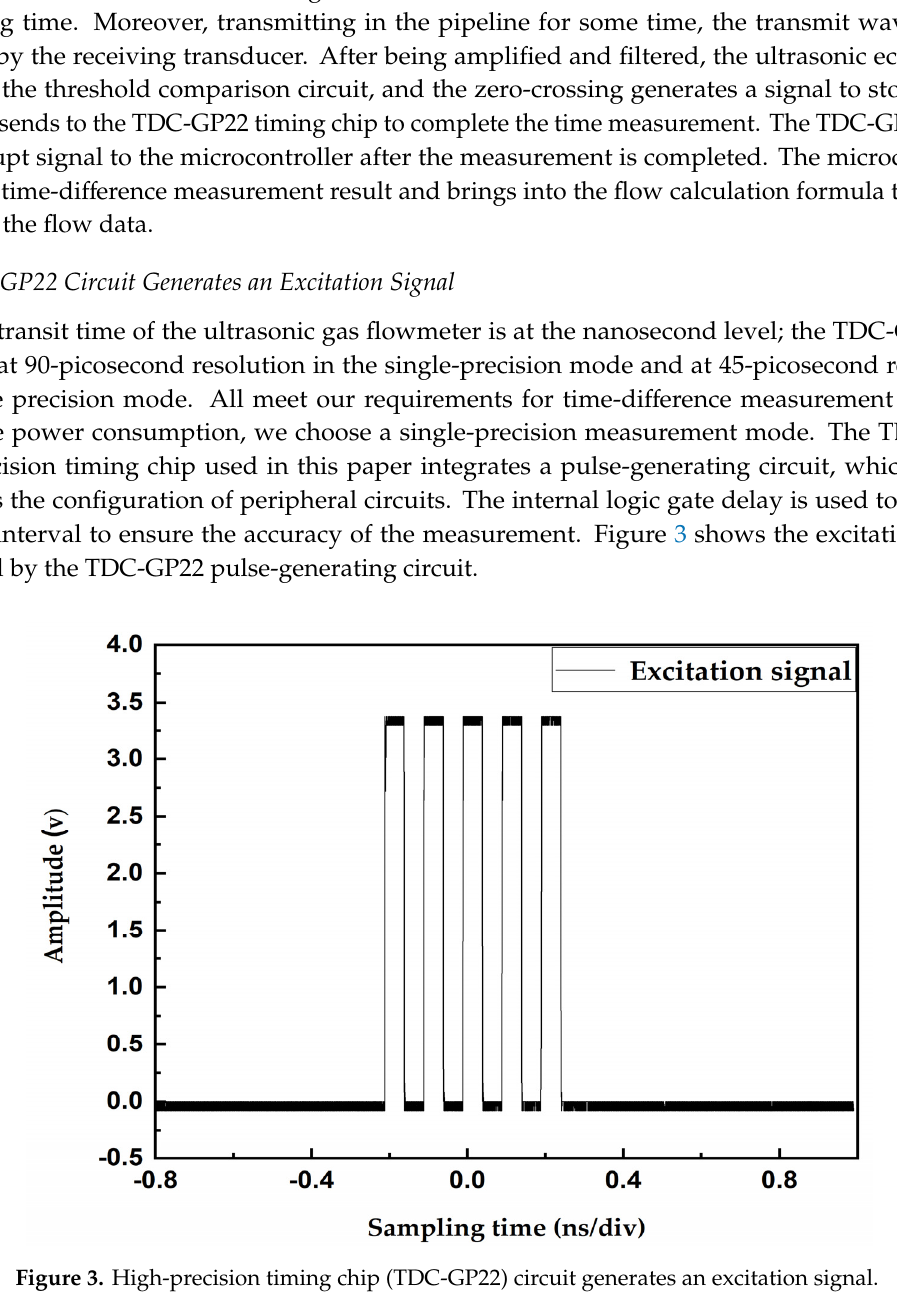
Figure 4. Amplified excitation signal by the amplifier circuit. 3.4. The Receiving Circuit Processes the Echo Signal After propagating through the fluid medium, the transmit waveform signal is received by the receiving transducer. Figure 5a shows the original echo signal generated by the receiving transducer